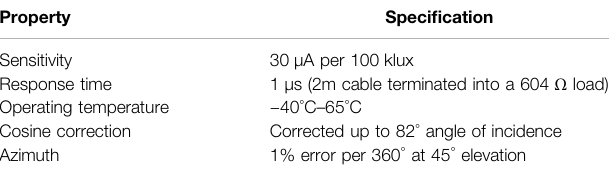
TABLE1| Speci fi cationsoftheLI-210Rcosinephotometricsensor(Biggs,2015).